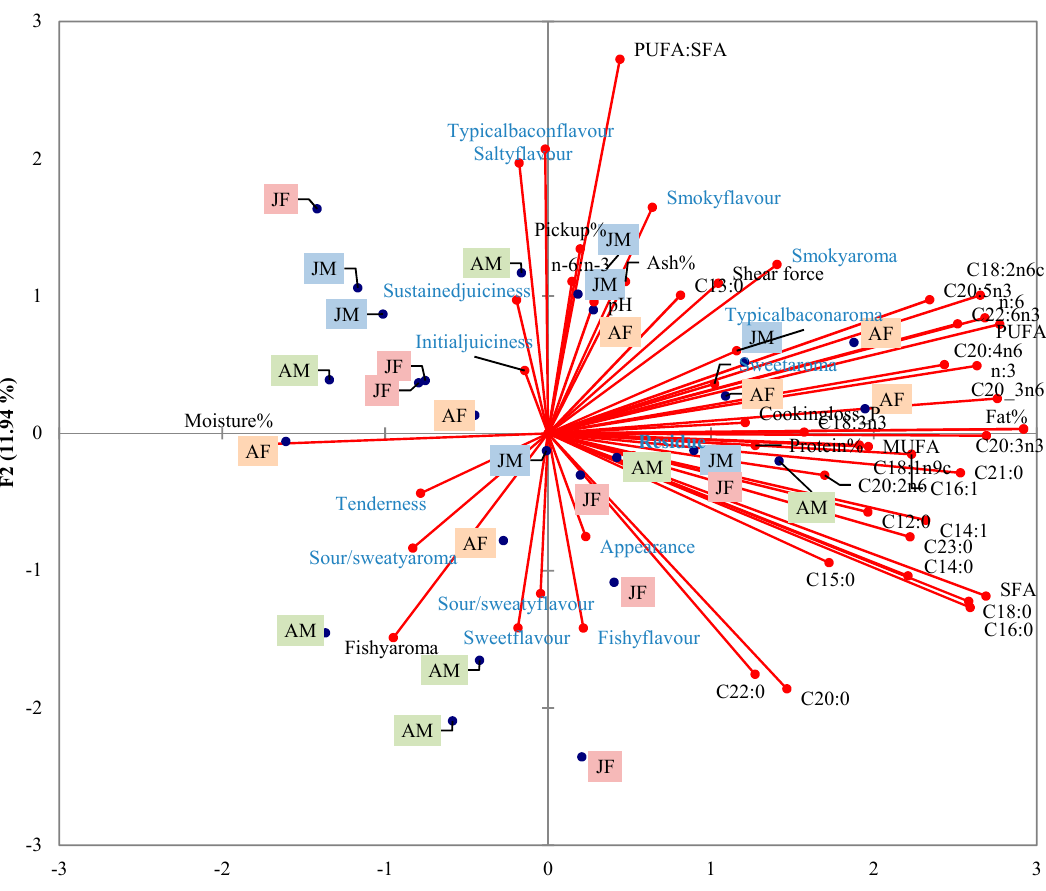
Figure 2. The principal component analyses (PCA) bi-plot of sensory attributes, physical attributes, proximate composition and fatty acid composition of warthog back bacon according to sex and age (AF = adult female, AM = adult male, JF = juvenile female, JM = juvenile male).